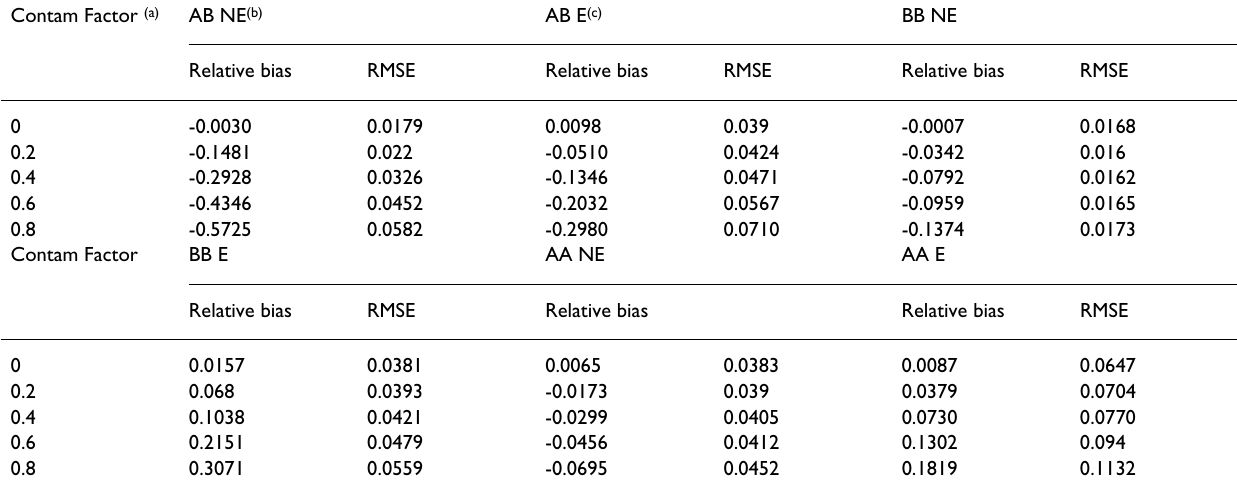
Table 1: Relative bias and RMSE of the disease risks predicted using the reduced model in the first scenario. Contam Factor (a)